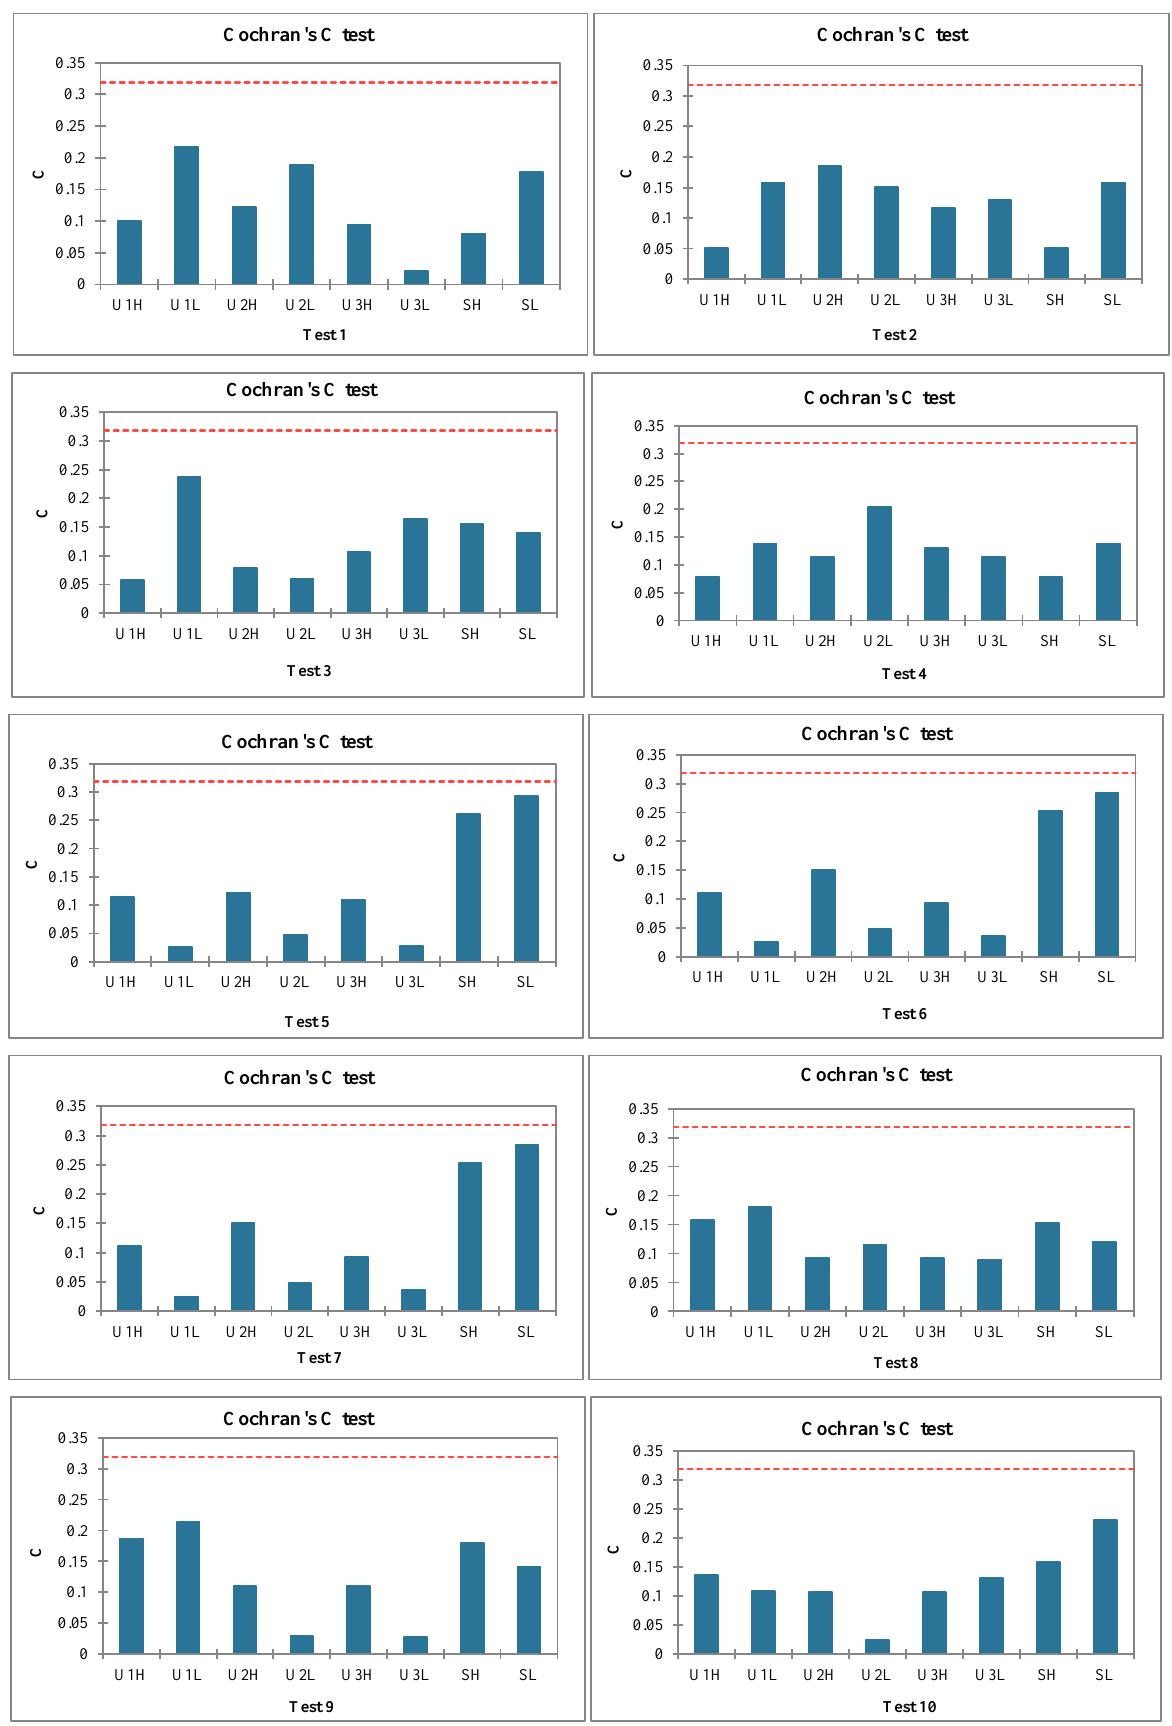
Figure 4. Cochran test for variance outlier detection in the treatment groups for ten microbiological assays of